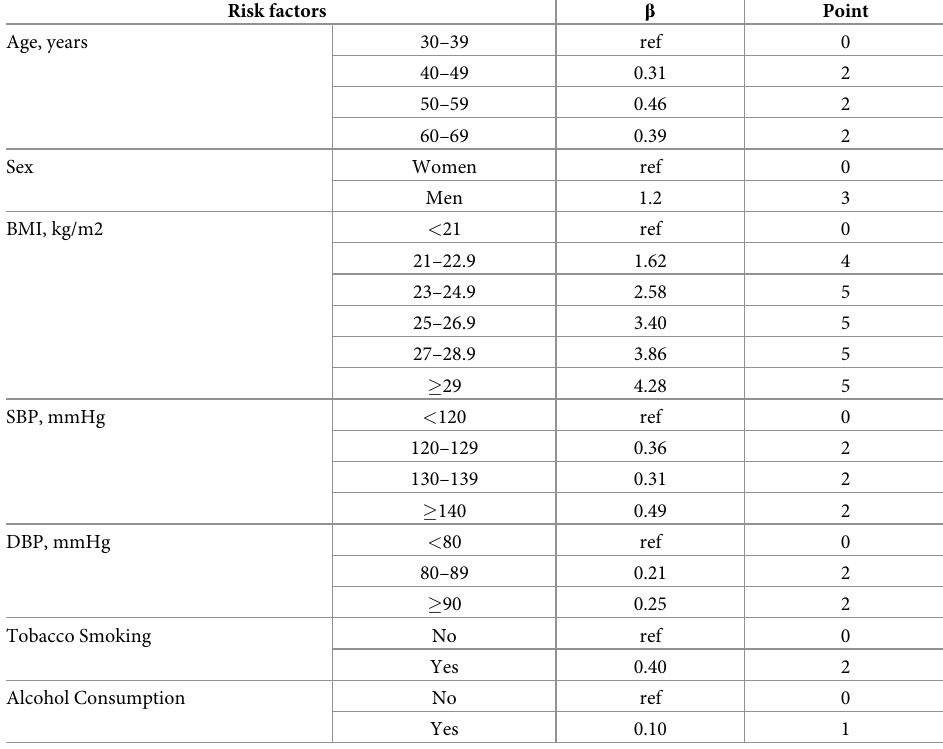
Table 5. Points assigned to risk factor in simple risk score (excluding blood tests) for predicting the 5-year meta- bolic syndrome incidence.